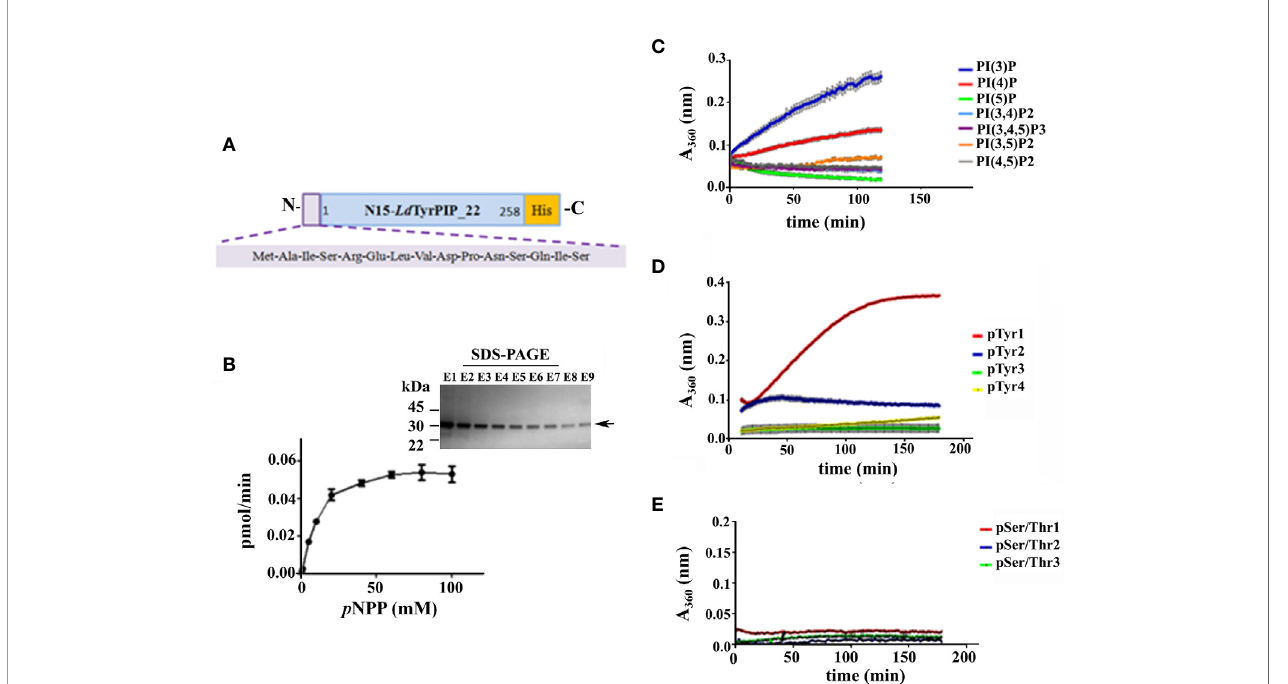
FIGURE 2 | Study of the catalytic properties and substrate speci fi city of the Ld TyrPIP_22. (A) Schematic representation of the r Ld TyrPIP_22 protein expressed in bacteria for this study (281 aa, with calculated Molecular mass: 32,062). (B) Michaelis-Menten saturation curve for the enzymatic reaction of the rN15- Ld TyrPIP_22- His (2 m M) using the p NPP (0.5 – 100 mM) as substrate. The reaction was performed at 25°C, pH 6. Inset: Coomassie stained SDS-PAGE of eluted fractions (E1-E9) from the puri fi cation of rN15- Ld TyrPIP_22-His from bacteria lysates ( Materials and Methods ) were analyzed on a 4% – 12% gradient SDS-PAGE gel. Arrow on the right side indicates the expected position for migration of the rN15- Ld TyrPIP_22-His polypeptide; Time course of dephosphorylation of PI species (100 m M) (C) , P-Tyr peptides (1 mM) (D) , and P-Ser/P-Thr peptides (60 m M) (E) . Peptide aa sequences are shown in Table S2 .